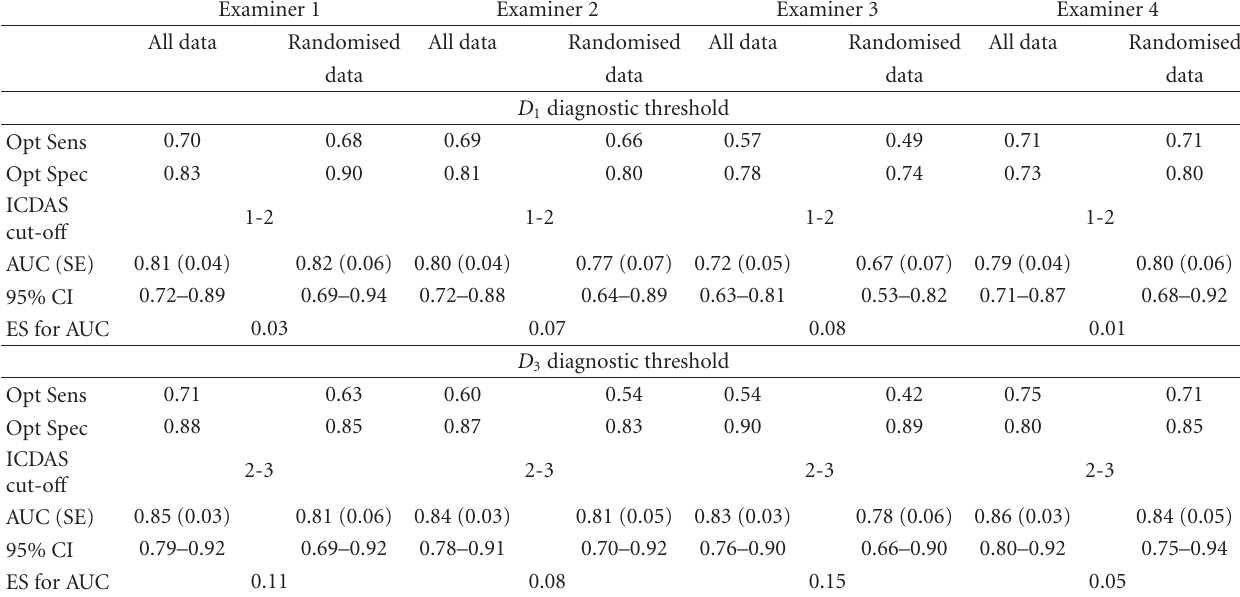
Table 4: The area under the ROC curve, optimum sensitivity and specificity and corresponding ICDAS-II threshold used, for each examiner at D 1 and D 3 diagnostic